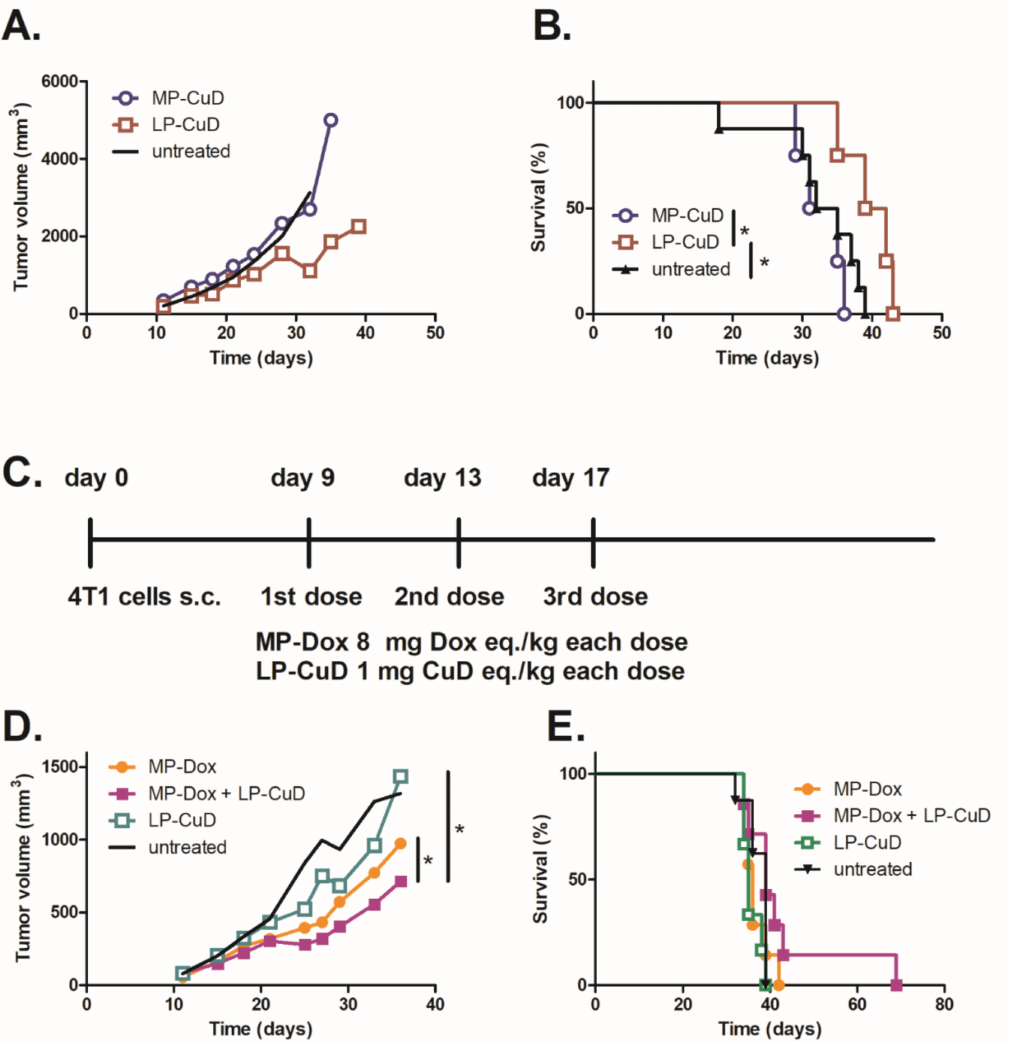
Figure 4. In vivo antitumor effect of the CuD-containing conjugates. The BALB/c mice were transplanted with 2 × 10 5 4T1 cells subcutaneously (s.c.) at day 0 and treated after the tumors developed to a measurable size. MP-CuD and LP-CuD were injected intravenously (i.v.) in three partial doses on days 8, 11, and 14, with each dose equivalent to 2.5 mg CuD/kg. Tumor growth ( A ) and survival ( B ) were monitored. No signs of systemic toxicity were recorded; n = 4 per condition. In the combination treatment, the mice were treated according to the dosing scheme ( C ). Tumor growth ( D ) and survival ( E ) are depicted. No systemic toxicity was recorded; n = 7 per group. Statistical significance: * p <